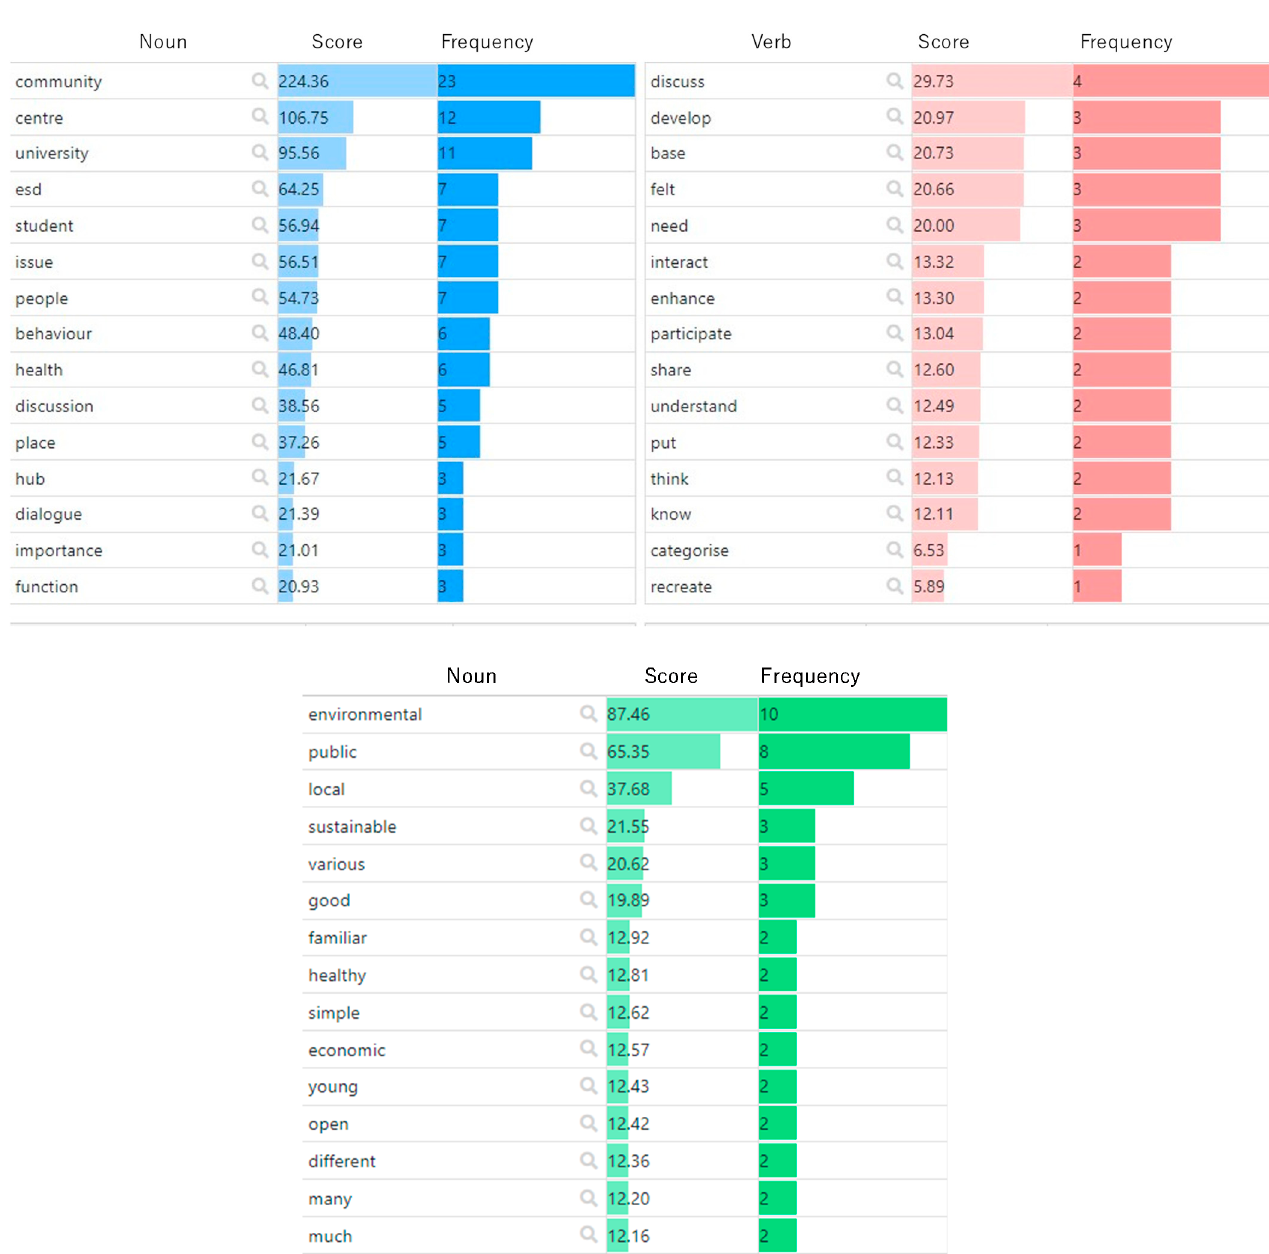
Figure 4. Frequent words by part of